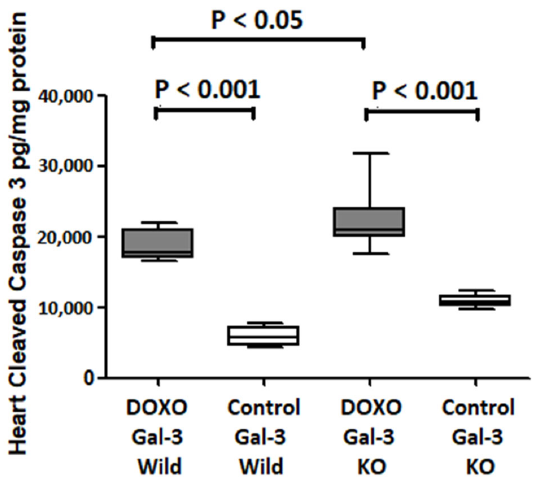
Figure 3. The graph represents heart concentrations of cleaved caspase-3 at 5 days follow DOXO treatment in Gal-3 wild type and Gal-3 KO mice compared to their sham controls. p value < 0.05 is statistically significant.